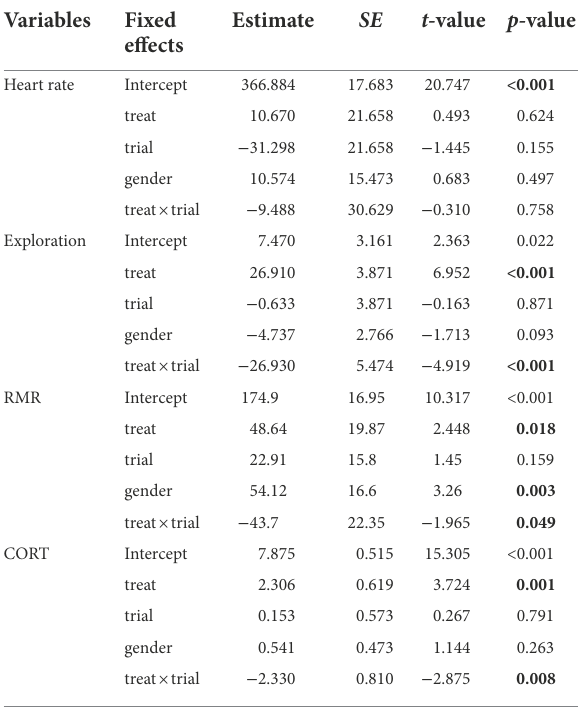
TABLE 2 Results from the LMM analyses with traffic noise and time as fixed effects and ID as the random effect.